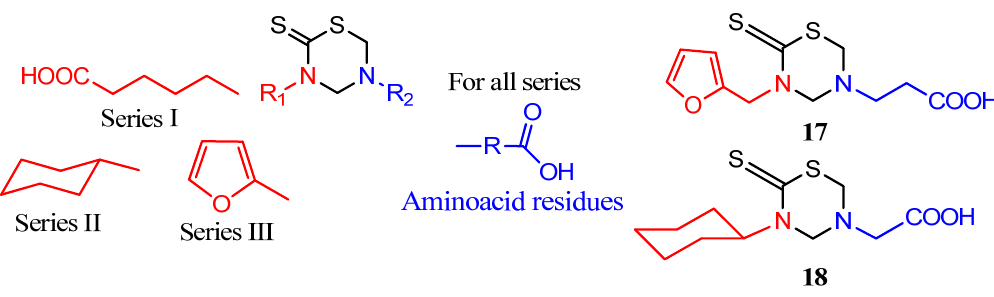
Figure 4. Mono-THTT derivatives tested against T. cruzi and T. vaginalis .